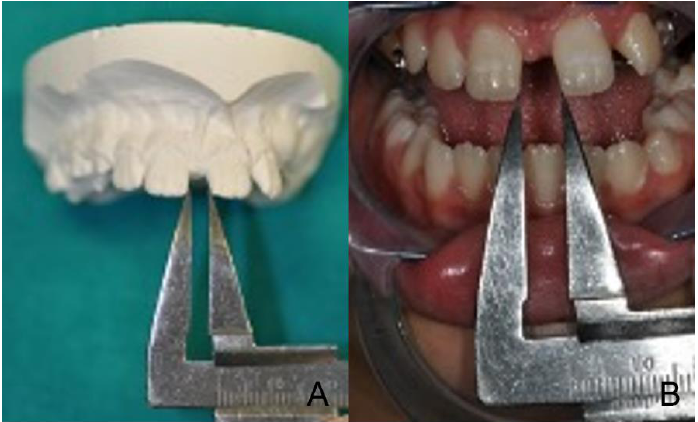
Figure 7. ( A ): Interincisive diastema control at the treatment onset = 4mm; ( B ): After 15 days of activations = 6 mm.